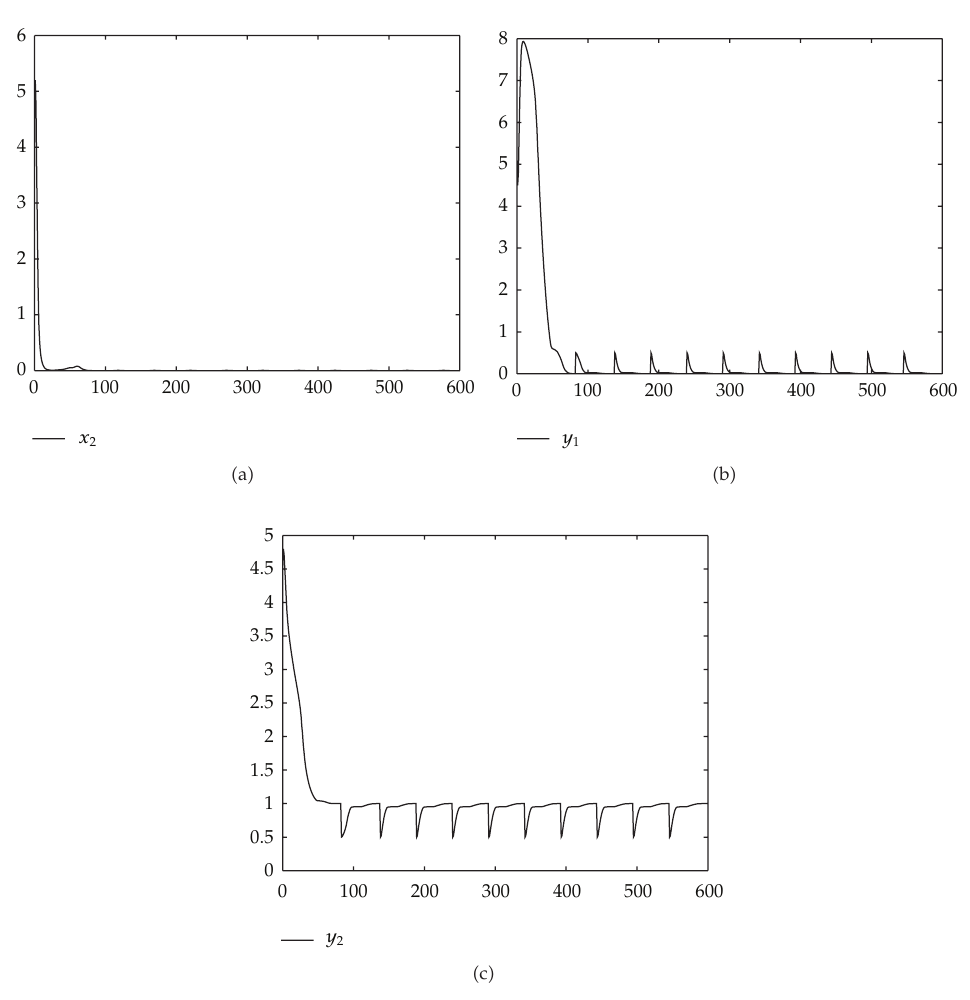
Figure 1: Dynamical behavior of system (cid:5) 2.5 (cid:6) on prey-extinction periodic solution with x 2 (cid:5) 0 (cid:6) (cid:8) 5 . 2, y 1 (cid:5) 0 (cid:6) (cid:8) 5 . 0, y 2 (cid:5) 0 (cid:6) (cid:8) 5 . 6, r (cid:8) 1, τ 1 (cid:8) 3, d (cid:8) 3, a 1 (cid:8) 1, a 2 (cid:8) 1, b 2 (cid:8) 1, β (cid:8) 4, k (cid:8) 0 . 9, D (cid:8) 0 . 5, w (cid:8) 1, and τ (cid:8) 1 . (cid:5) a (cid:6) Time-series of x (cid:5) t (cid:6) , (cid:5) b (cid:6) time-series of y (cid:5) t (cid:6) , (cid:5) c (cid:6) time-series of y (cid:5) t (cid:6) 2 1 2